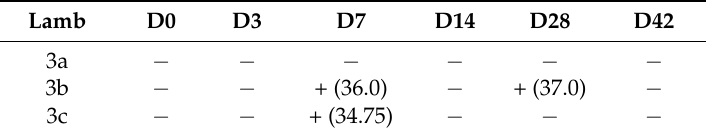
Table 2. qPCR results of blood samples from triplet lambs (3a–3c) analyzed for A. phagocytophilum , from birth (D0) to day 42 (D42) (+ = positive; − = negative). Crossing point (Cp)-values in parenthesis.